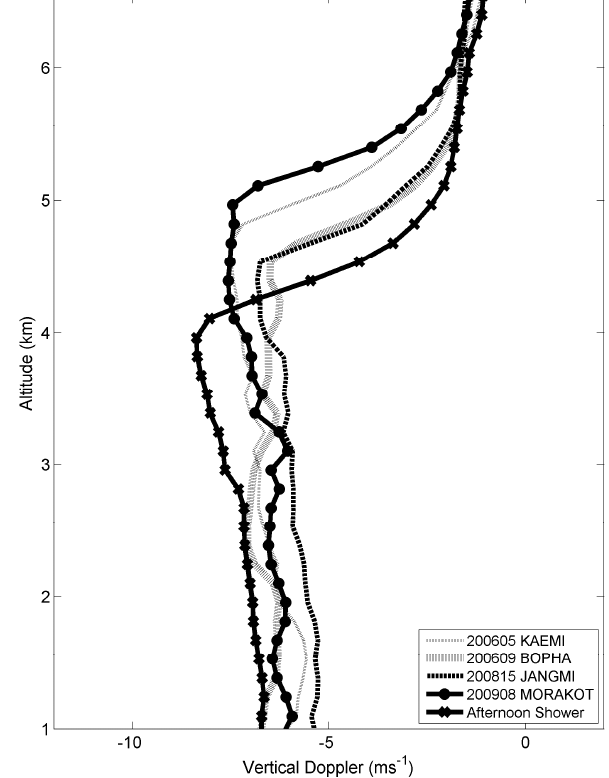
Fig.3: Vertical profiles of Doppler velocity observed during passage of four typhoons and showery precipitation overhead of the wind profiler. Fig. 3. Vertical profiles of Doppler velocity observed during pas- sage of four typhoons and showery precipitation overhead of the wind